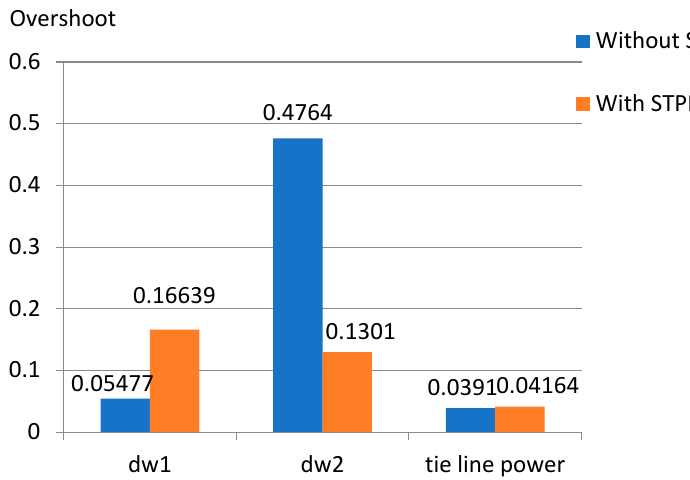
Figure 18. Undershoot variations with step load perturbation.